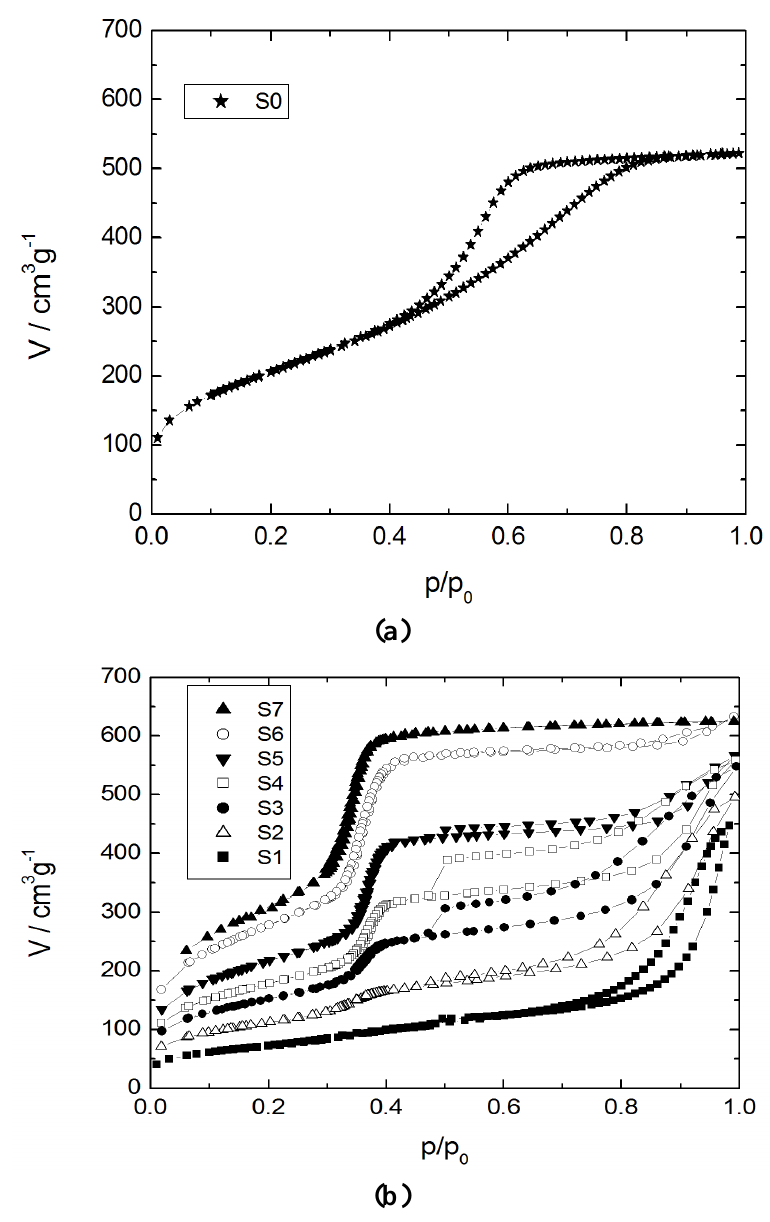
Figure 1. Nitrogen sorption isotherms at 77 K for ( a ) the initial silica gel S0; and ( b ) the transformation products